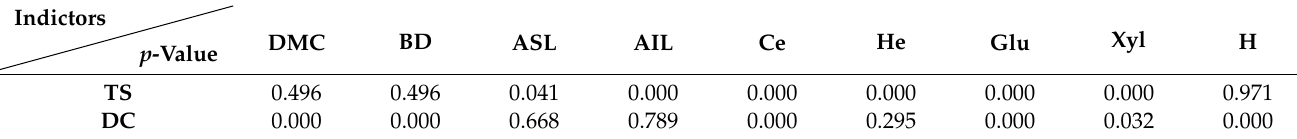
Table 2. ANOVA test for the differences in physicochemical properties among different tree species and decay classes (hardness clustering results). ( p -value) TS, tree species; DC, decay class; BD, basic density; ASL, acid-soluble lignin; AIL, acid-insoluble lignin; Ce, cellulose; He, hemicellulose; Glu, glucose; Xyl, xylose; H, hardness.